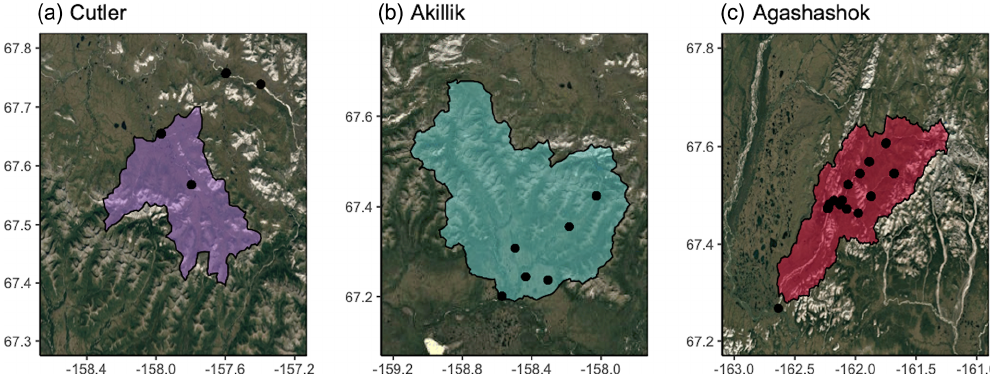
Figure 3. Synoptic sampling sites in three NPS/USGS watersheds. Study watersheds include the (a) Cutler, (b) Akillik, and (c) Agashashok rivers. Map created in R Studio (version 1.2.1335) with base imagery from ESRI and © Google Earth (version 7.3.3.7786). Table 2. Description of the sampling campaign regimes, including dates for each campaign, for the TFS and NPS/USGS watersheds. Site Years of Number of Sampling dates Seasonal repeated sampling sampling synoptic events sampling